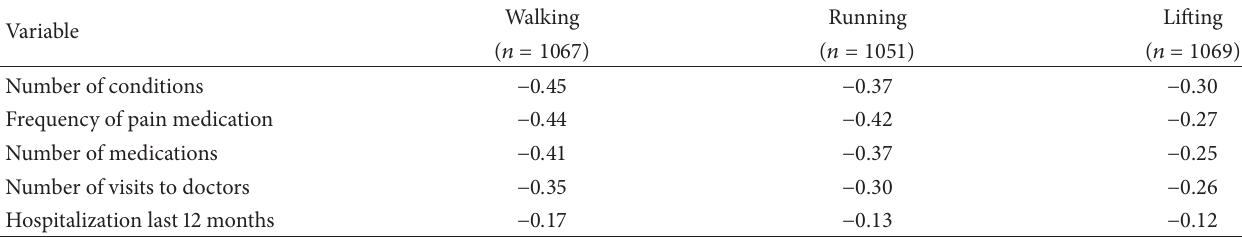
Table 4: Relationships between summary ability scores and number of conditions, medication, visits to doctors, and hospitalization (standardized regression coefficients).